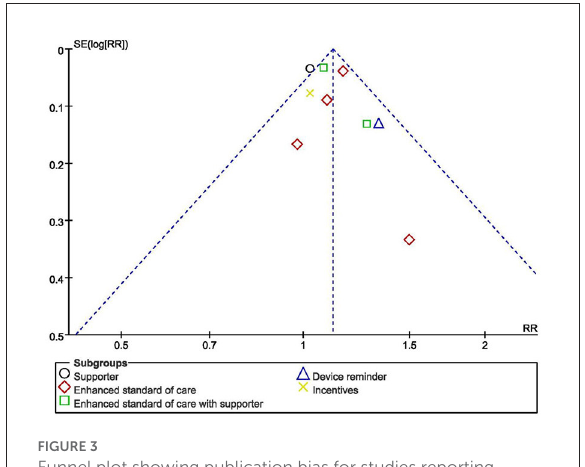
FIGURE3 Funnel plot showing publication bias for studies reporting impact on adherence to medication of HIV + pregnant